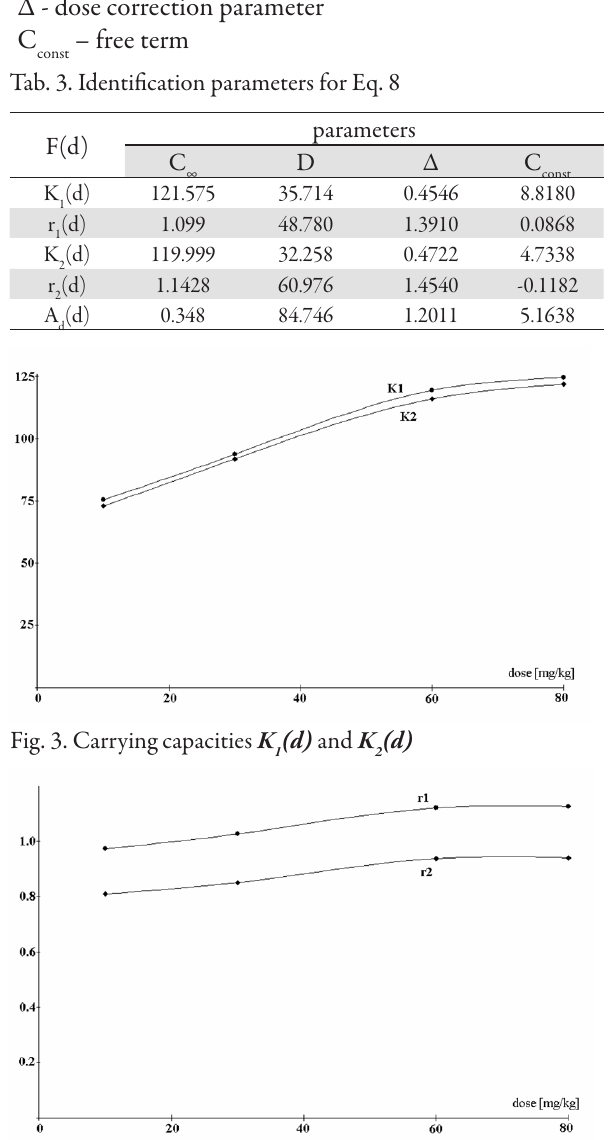
Fig. 4. Growth rate r